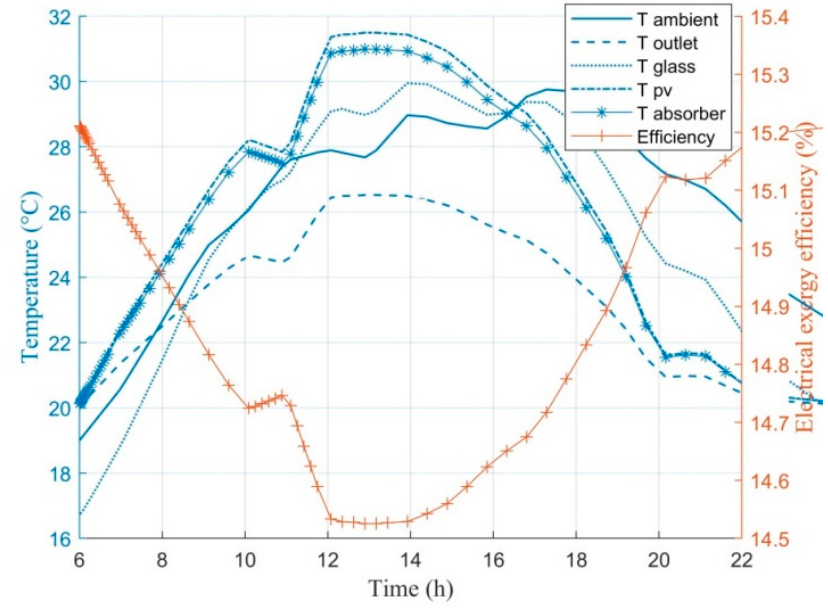
Figure 7. The electrical exergy e ffi ciency, PVT surface, fluid outlet and ambient temperature during a summer day.